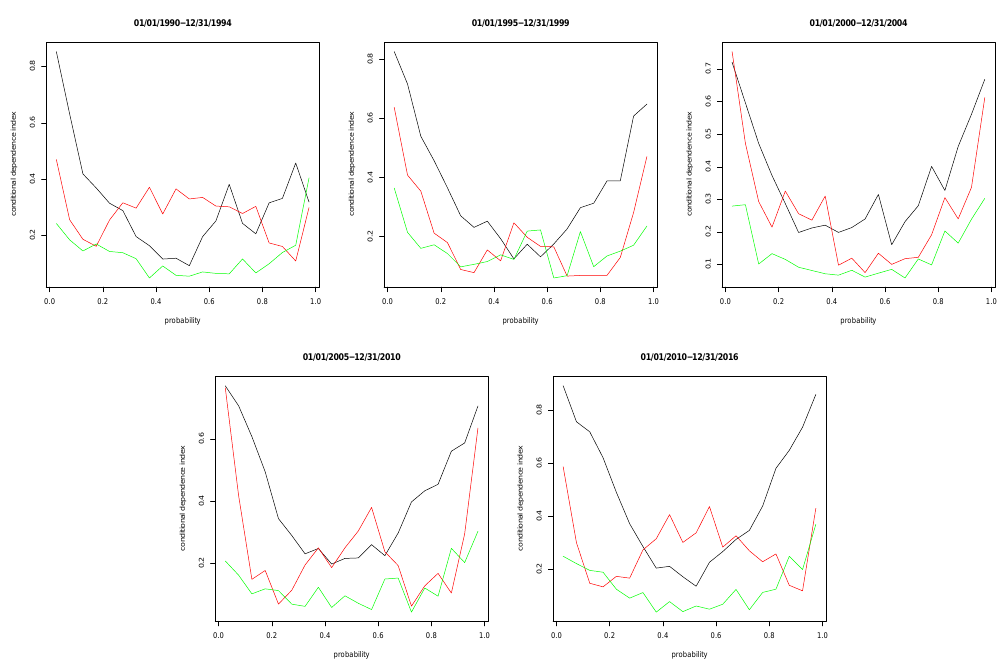
Figure 6. Subsample Conditional Dependence Index Estimates (black: rvix | rsp; red: VIX 2 | rsp; green: rsp | VIX 2